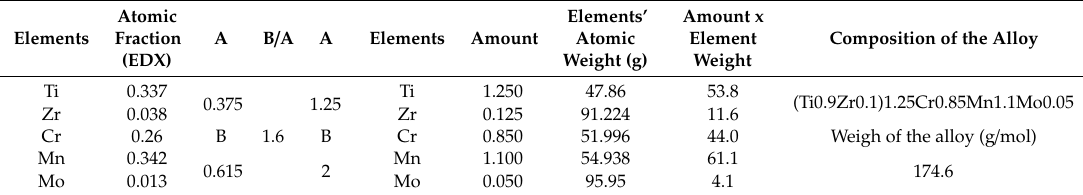
Table A1. Nominal composition of the and weight of the non-stoichiometric AB 2